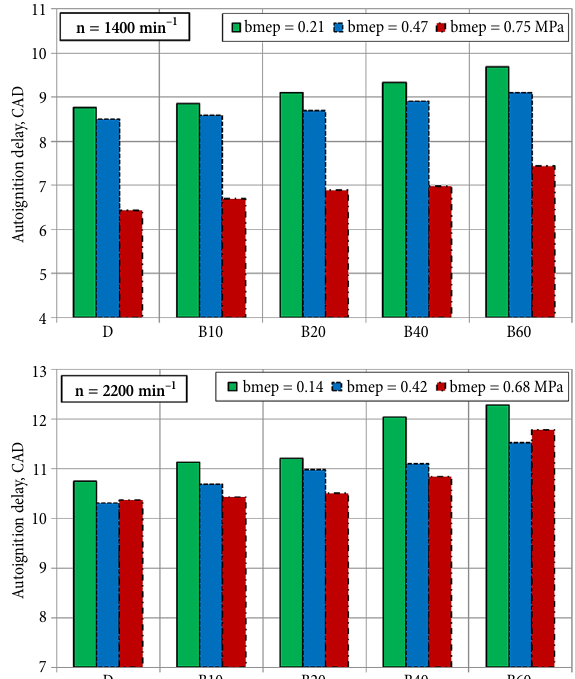
Fig. 3. Dependence of auto-ignition delay on engine load (Brake Mean Effective Pressure – bmep ) and RME amount in the fuel